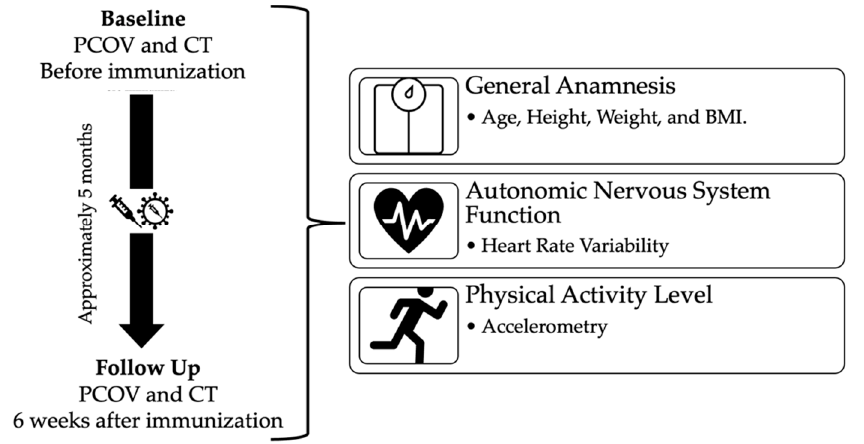
Figure 1. Study design. Evaluations performed on participants at baseline and after a minimum six weeks following complete immunization (follow-up).